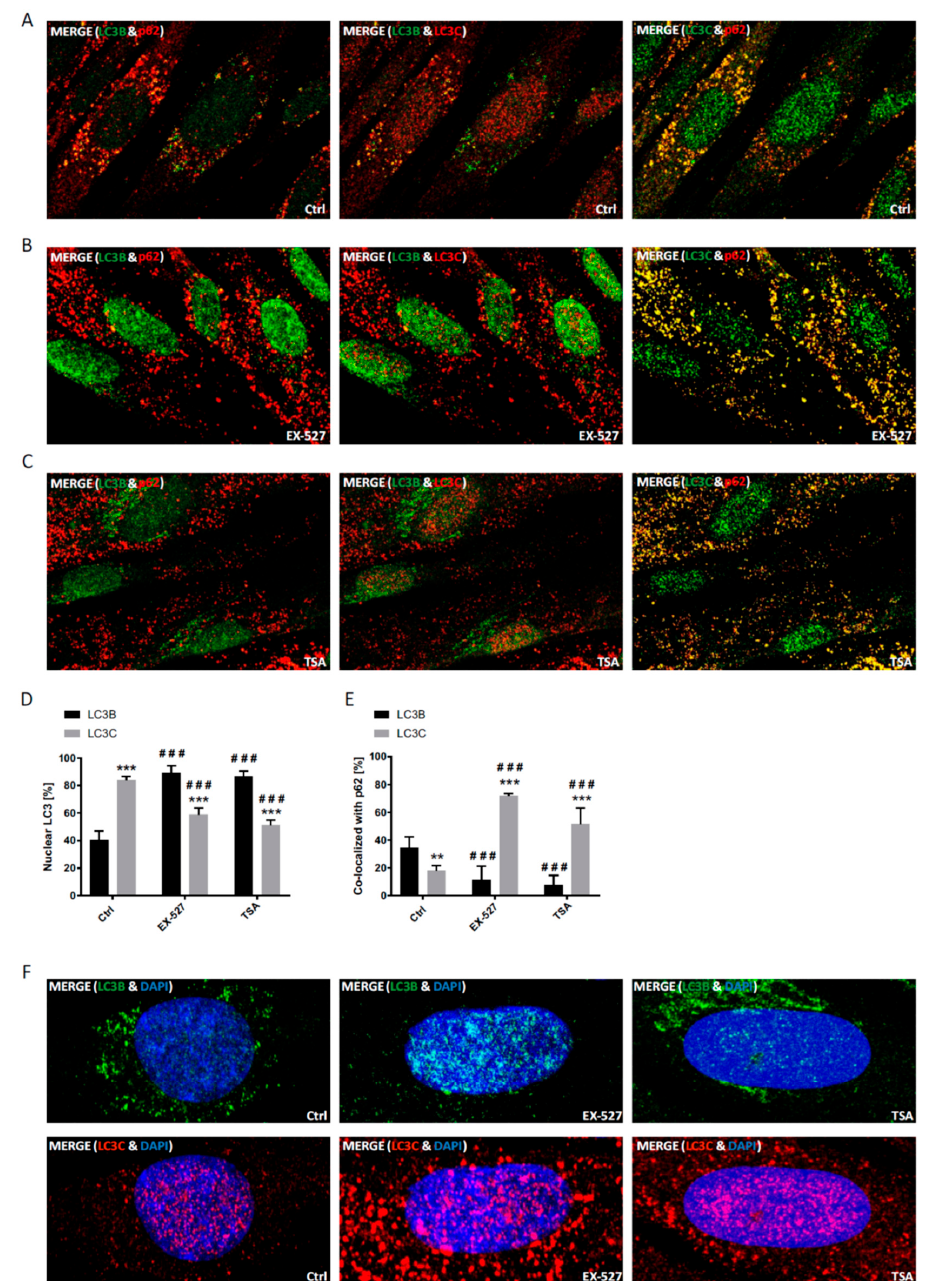
Figure 4. Analysis of the cellular localization of LC3C and LC3B in response to pharmacological sirtuin inhibition. Primary human fibroblasts were treated with BafA1, Ex527 or TSA and analyzed as in Figure 3. ( A ) Cellular localization of LC3C, LC3B and p62 after treatment with BafA1 alone. ( B ) Cellular localization of LC3C, LC3B and p62 after treatment with Ex527 and BafA1. ( C ) Cellular localization of LC3C, LC3B and p62 after treatment with TSA and BafA1. ( D ) Quantification of the relative nuclear fraction of LC3C and LC3B in cells treated as indicated. Significant changes (by two-way ANOVA) versus the control: ### p ≤ 0.001; significant changes between the LC3s: ** p ≤ 0.01; *** p ≤ 0.001. ( E ) Relative co-localization of LC3C and LC3B with p62 quantified by image analysis. Statistical analysis was done as in D. Data in ( D ) and ( E ) were derived from three photographed, independent experiments ( n = 3), in which 12–45 cells per image were analyzed. ( F ) Magnified images of cells immunostained for LC3C or LC3B including the chromatin counterstain